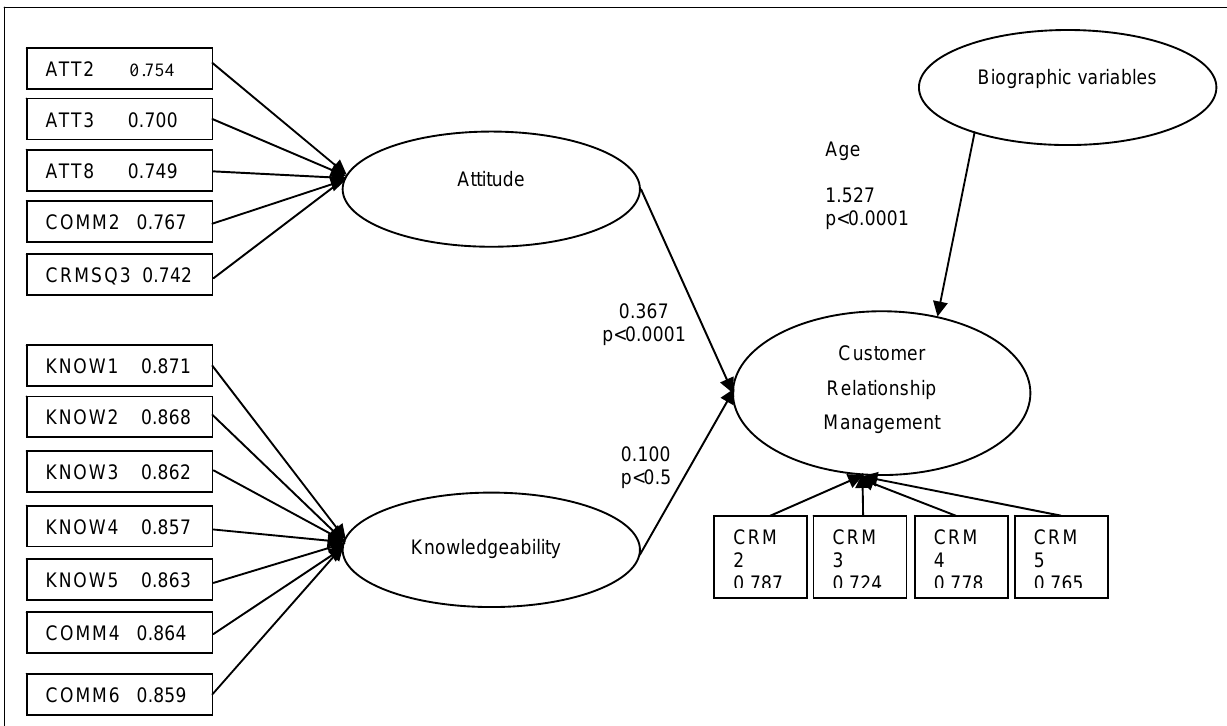
Figure 2: Modified